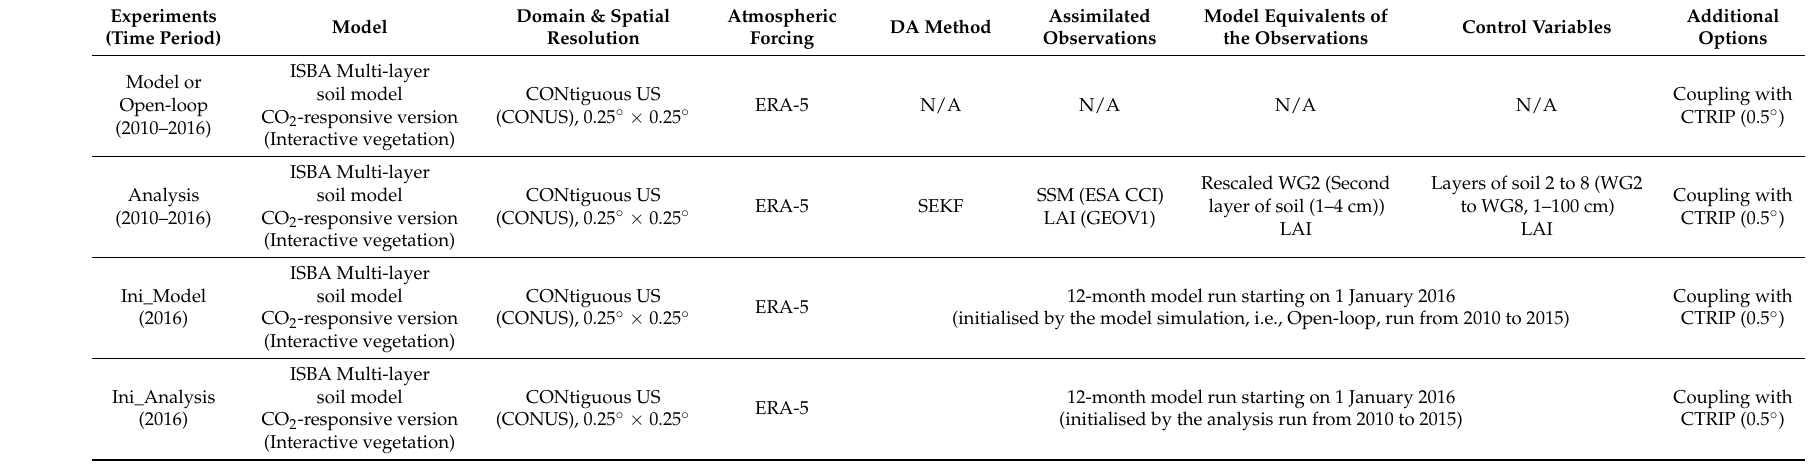
Table 1. Set up of the experiments used in this study. ISBA—interactions between soil, biosphere, and atmosphere; DA—data assimilation; SEKF—simplified version of an extended Kalman filter; ESA CCI SSM—European Space Agency and Climate Change Initiative surface soil moisture; LAI—leaf area index; CTRIP—Centre National de Recherches M é t é orologiques version of the total runoff integrating